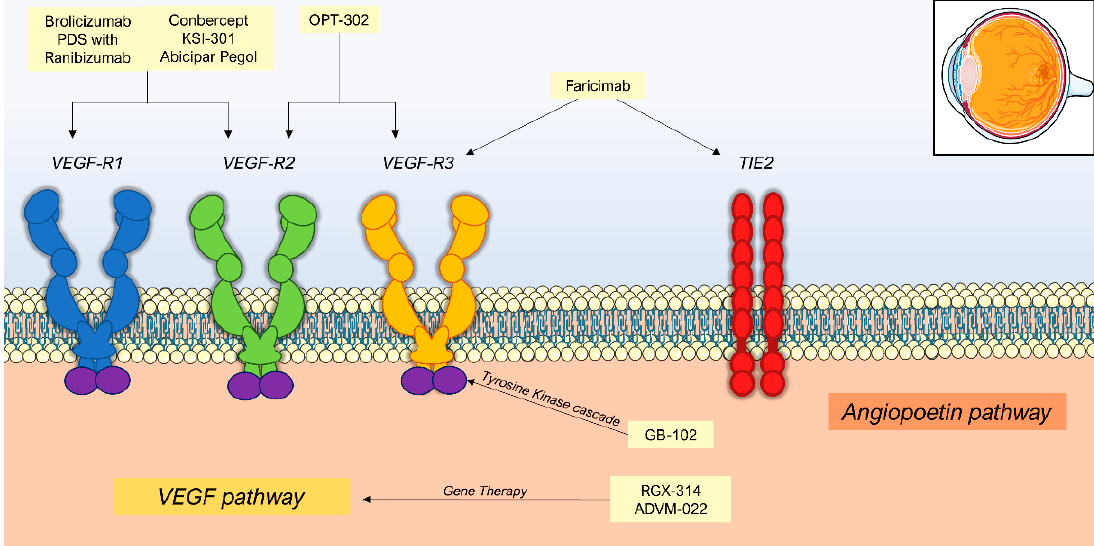
Figure 1. Mechanisms of action of Neovascular age-related macular degeneration therapies in development.